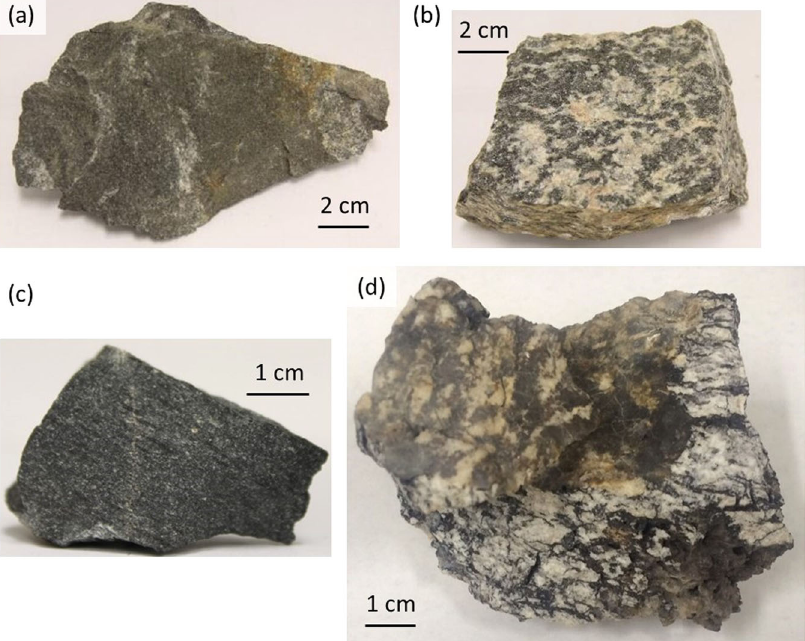
Fig. 1 Photographs of the samples collected from Broborg. a BA5 amphibolite, ( b ) 443 Granite, ( c ) Dike amphibolite, ( d )